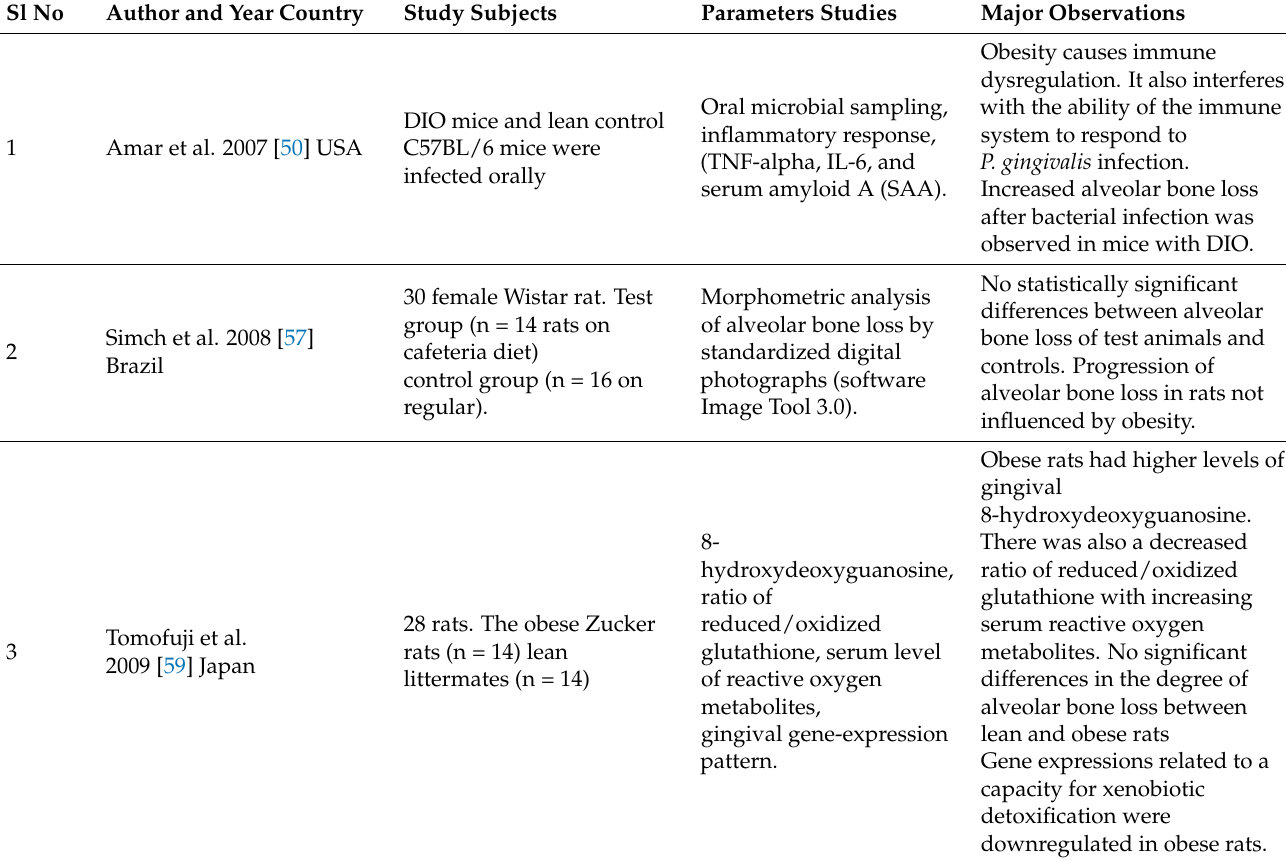
Table 2. Animal studies included in the